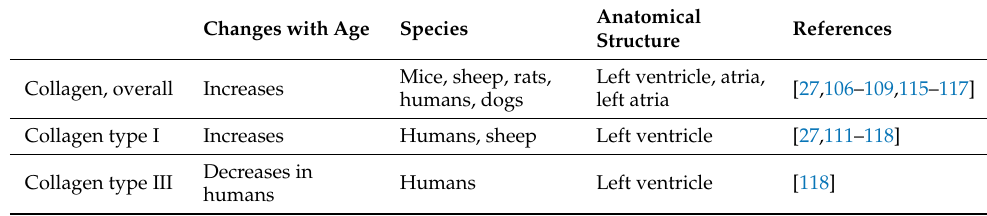
Table 2. Age-related changes in collagen, fibronectin, laminin, integrin, mimecan and SPARC in atria and